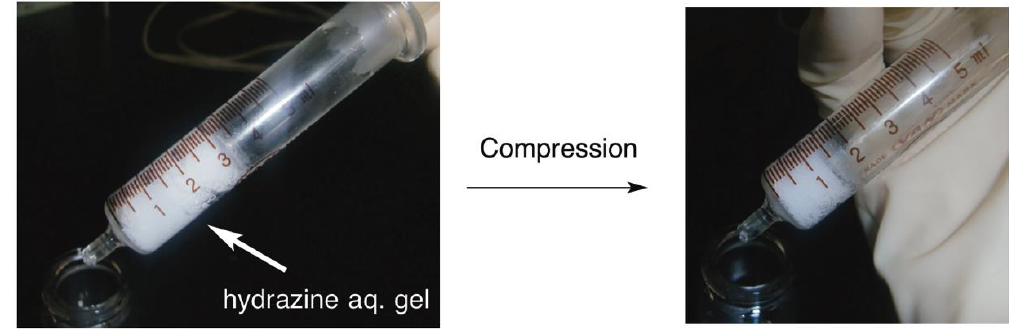
Figure 4. Releasing of hydrazine from hydrazine gel by compression.